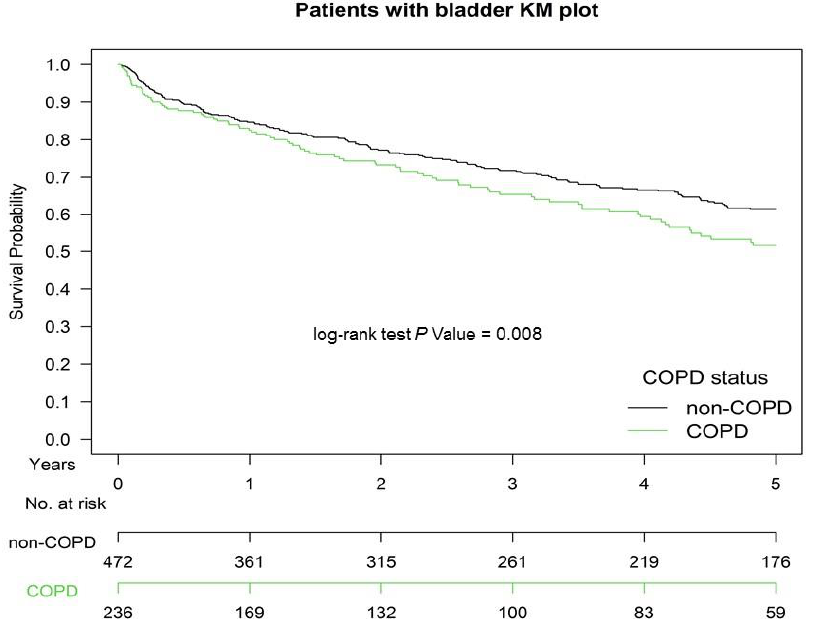
Figure 1. Kaplan–Meier (KM) survival curves of propensity score-matched patients with muscle-invasive urothelial carcinoma of the bladder with and without current-smoking-related COPD before definitive CCRT for bladder preservation, COPD, chronic obstructive pulmonary disease; CCRT, concurrent chemoradiotherapy.